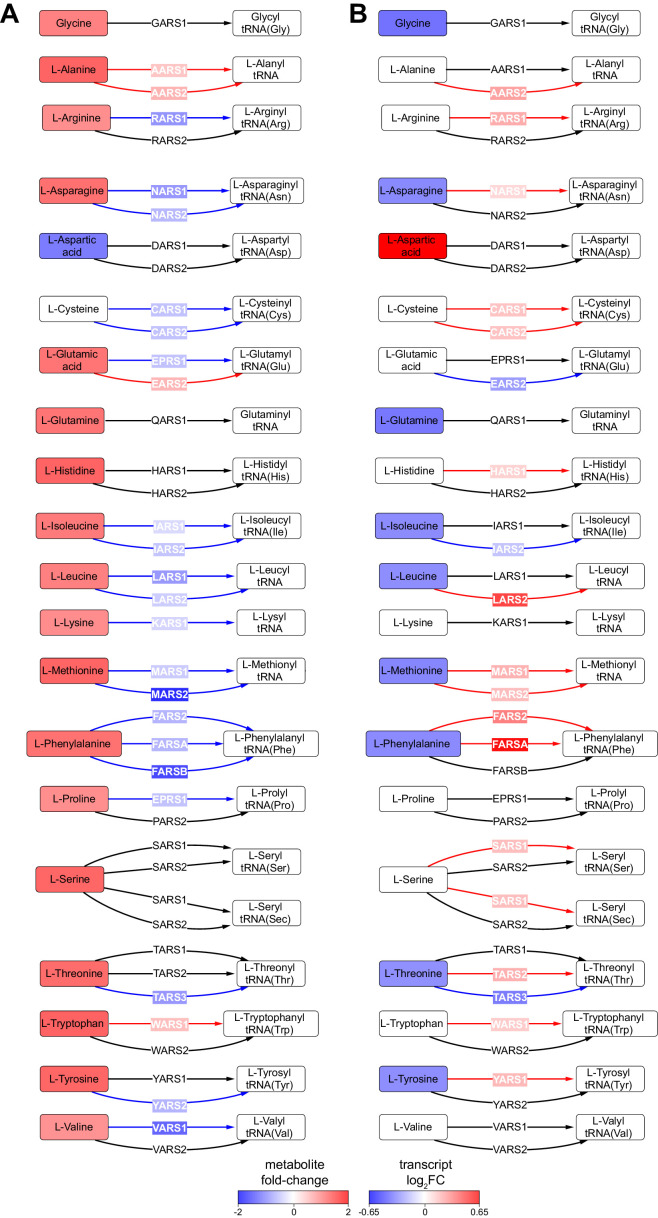
Amino acids and their cognate tRNA-ligases are influenced by the MYC–host cell factor (HCF)–1 interaction.Impact of the 4A (A) and VP16 HCF-1-binding motif (B) mutants on amino acid levels (hydrophilic interaction liquid chromatography) and on the expression of aminoacyl tRNA transferases (RNA-Seq).